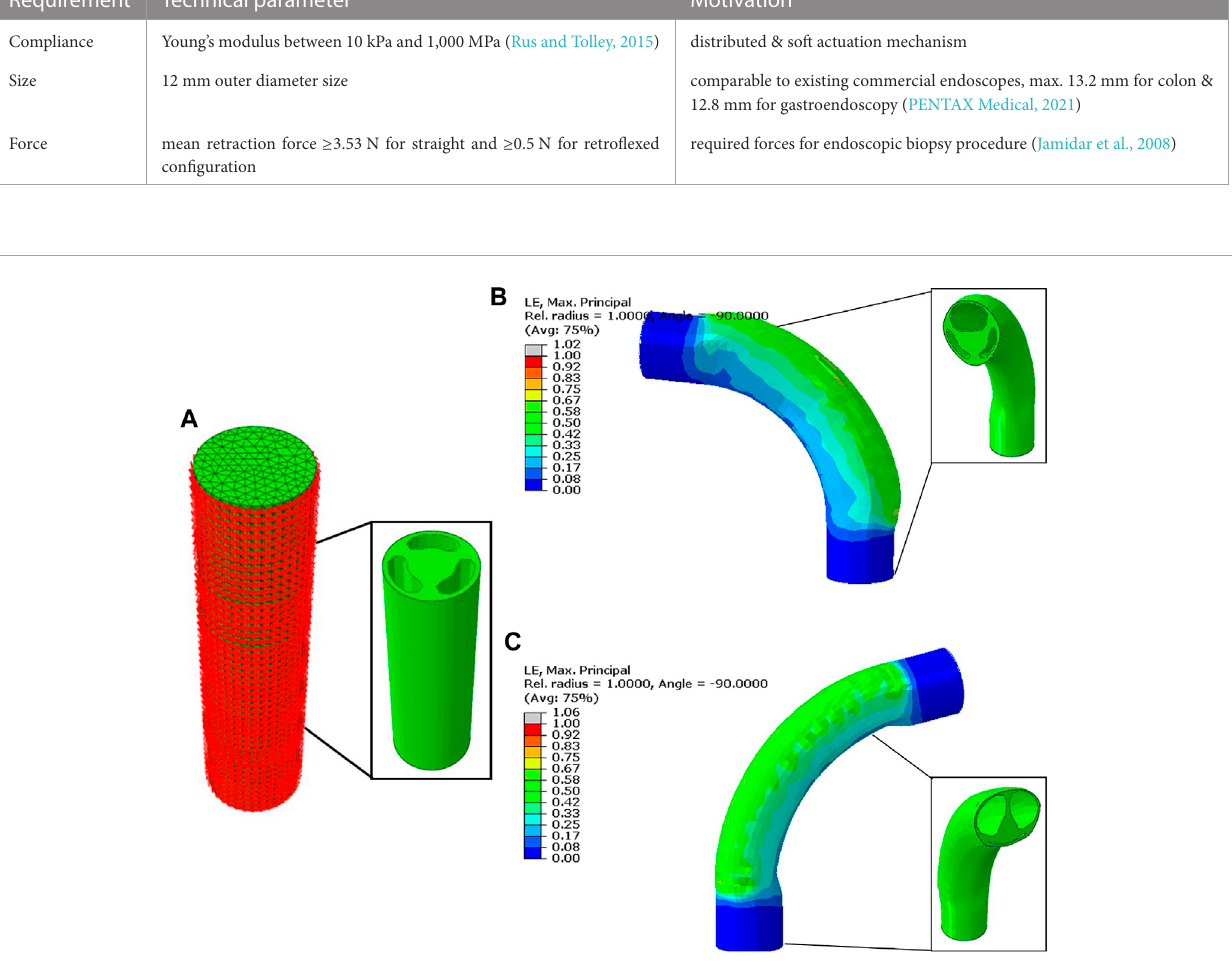
FIGURE 1 The developed FE model of the soft pneumatic actuator with the outer fiber reinforcement constraint (A) . The bending performance is simulated for the case of single chamber pressurization (B) , and pressurization of two chambers at once (C)